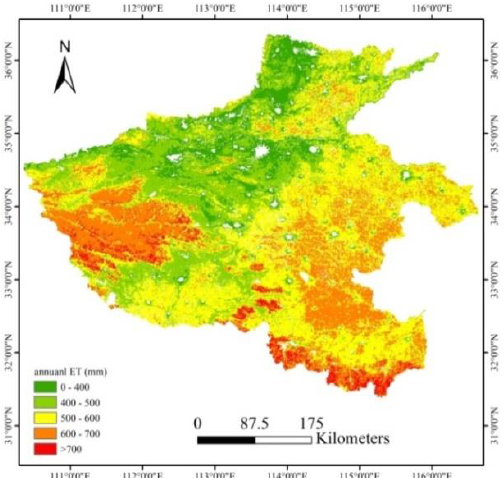
Figure 7. Spatial distribution of annual average ET during 2000 – 2020.